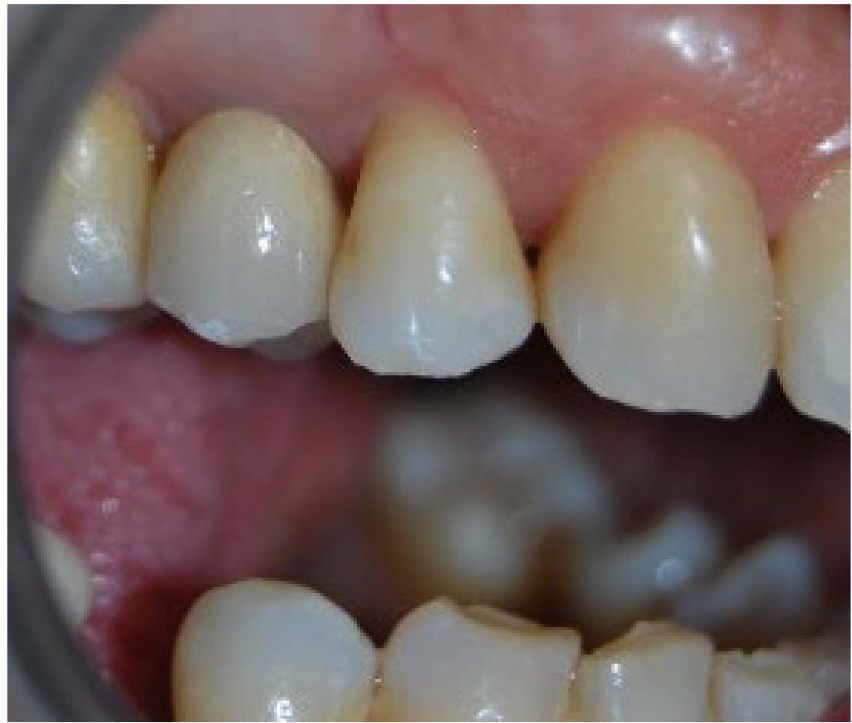
Figure 1. Two-year clinical follow-up. Clinical photo 2 years after implantation.